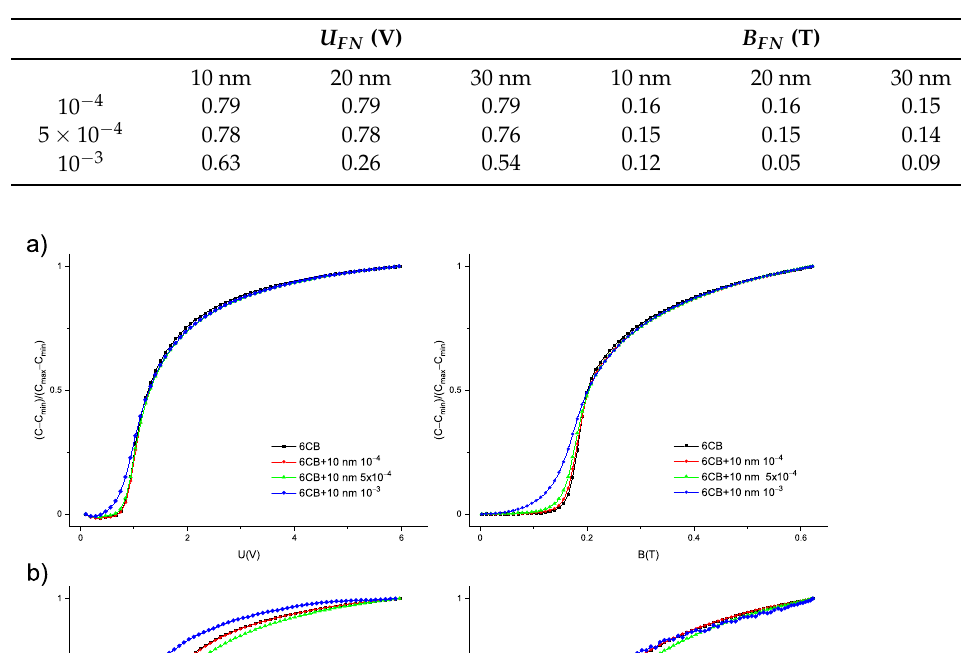
Table 1. Threshold voltage U FN and threshold magnetic field B FN for composites acquired from data presented in Figure 4. The threshold voltage of pure 6CB is U LC = 0.79 V and threshold magnetic field B LC = 0.16 T.